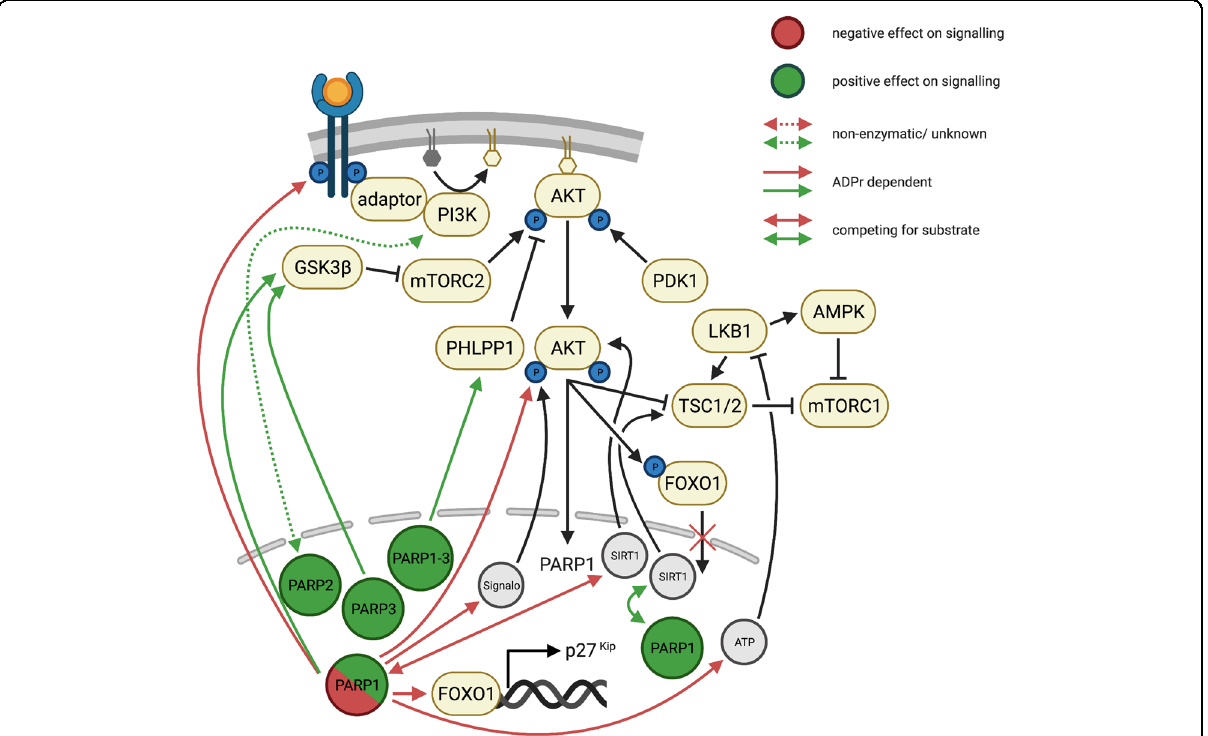
Fig. 5 Schematic overview of the interplay between AKT signaling and ARTD family members. Positive regulations of AKT signaling by ARTD family members are depicted in green, while negative effects of ARTDs on the signaling pathway are shown in red. Solid lines indicate the contribution of ADP-ribosylation or competition for substrate in the regulation of AKT signaling. In case the contribution of ADP-ribosylation was not described or the protein itself rather than its enzymatic activity is involved in the regulation, the interactions are represented by dashed